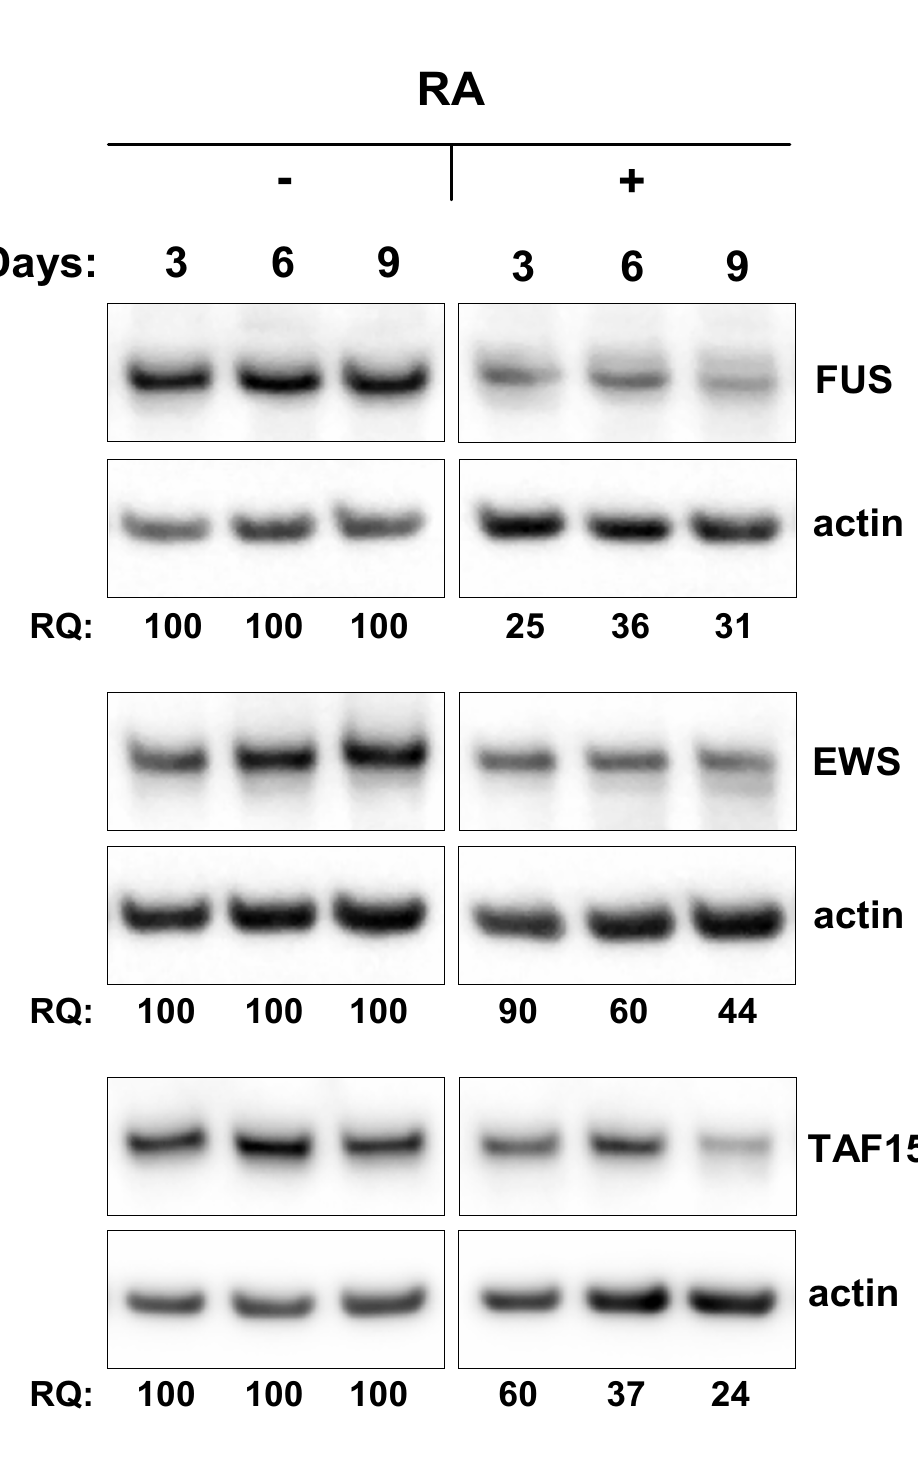
Figure 6 FET expression is reduced during neuronal differentiation of SH-SY5Y neuroblastoma cells . Cells were treated with 1 μ M of all-trans retinoic acid and lysed at different time points. Relative quantification (RQ) values were obtained by nor- malizing FET expression against beta actin expression in each sample and by further comparing RA treated with untreated cells at each time point. Data from one of two independent experiments yielding similar